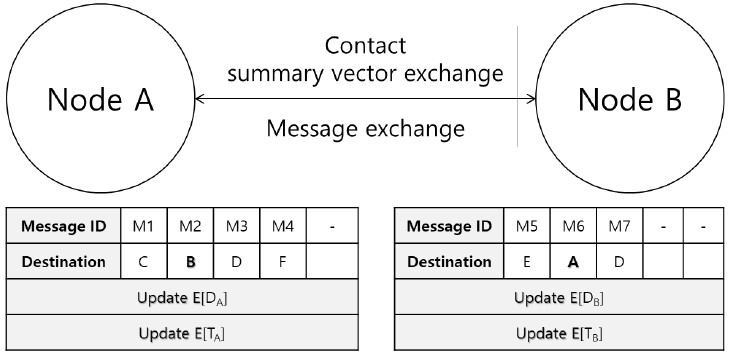
Figure 2. A scenario of update of average distance and average time.